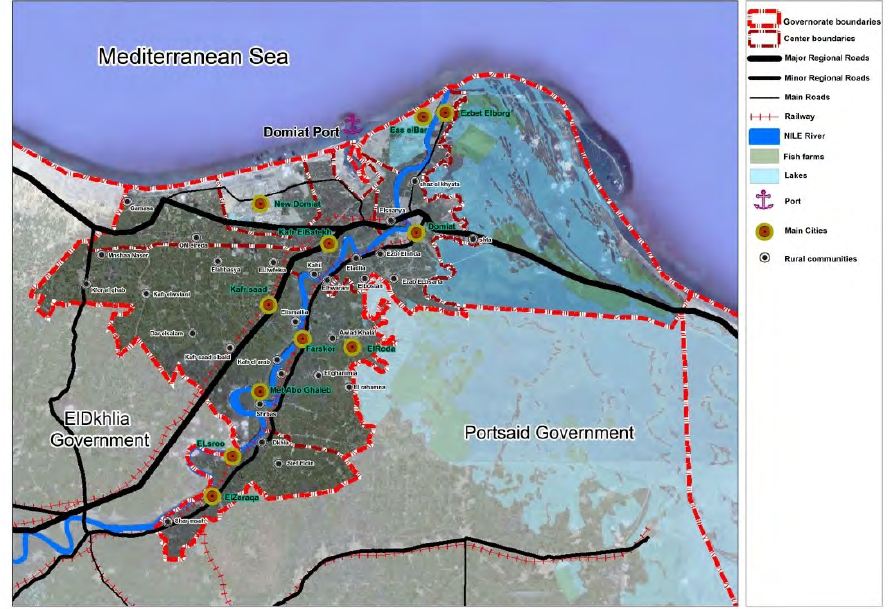
Figure 1. Shows the location of Damietta Governorate in Delta